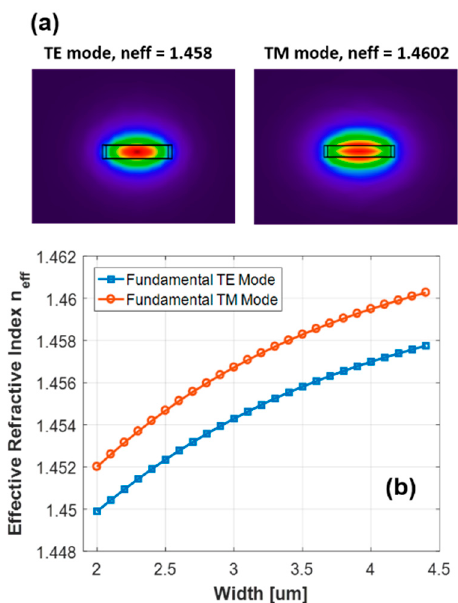
Figure 8. ( a ) Fundamental TE and TM modes of the SiOC waveguide (W = 4400 × H = 400 nm 2 ) and their respective effective indices n eff computed with FEM based software, ( b ) Plot of effective refractive index n eff of SiOC waveguide modes as a function of increasing width (2–4.4 μ m), only fundamental TE and TM modes exist at λ = 1550 nm.